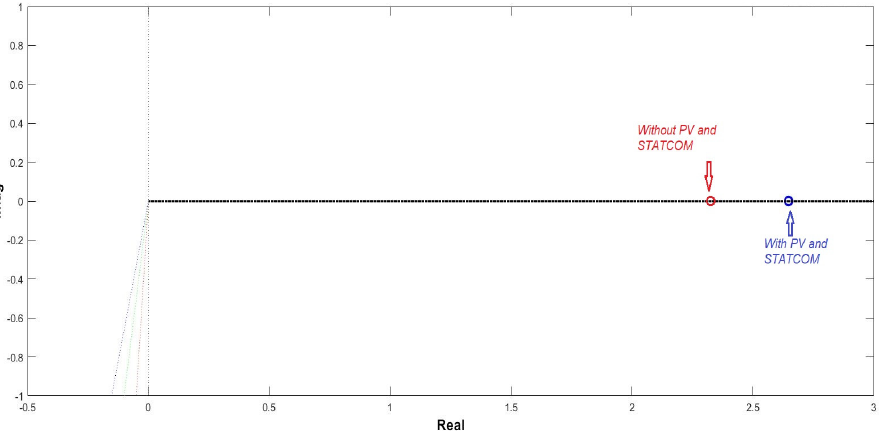
Figure 23. Eigenvalue locus of the static load flow Jacobian matrix with and without PV and STAT ‐ COM.